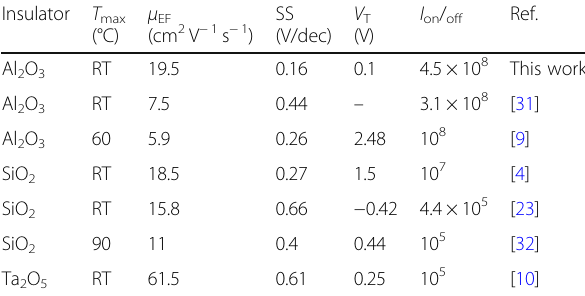
Table 1 Comparison of the electrical parameters of our RT Al 2 O 3 a-IGZO TFT and other a-IGZO TFTs fabricated at low temperatures ( T max denotes the maximum process